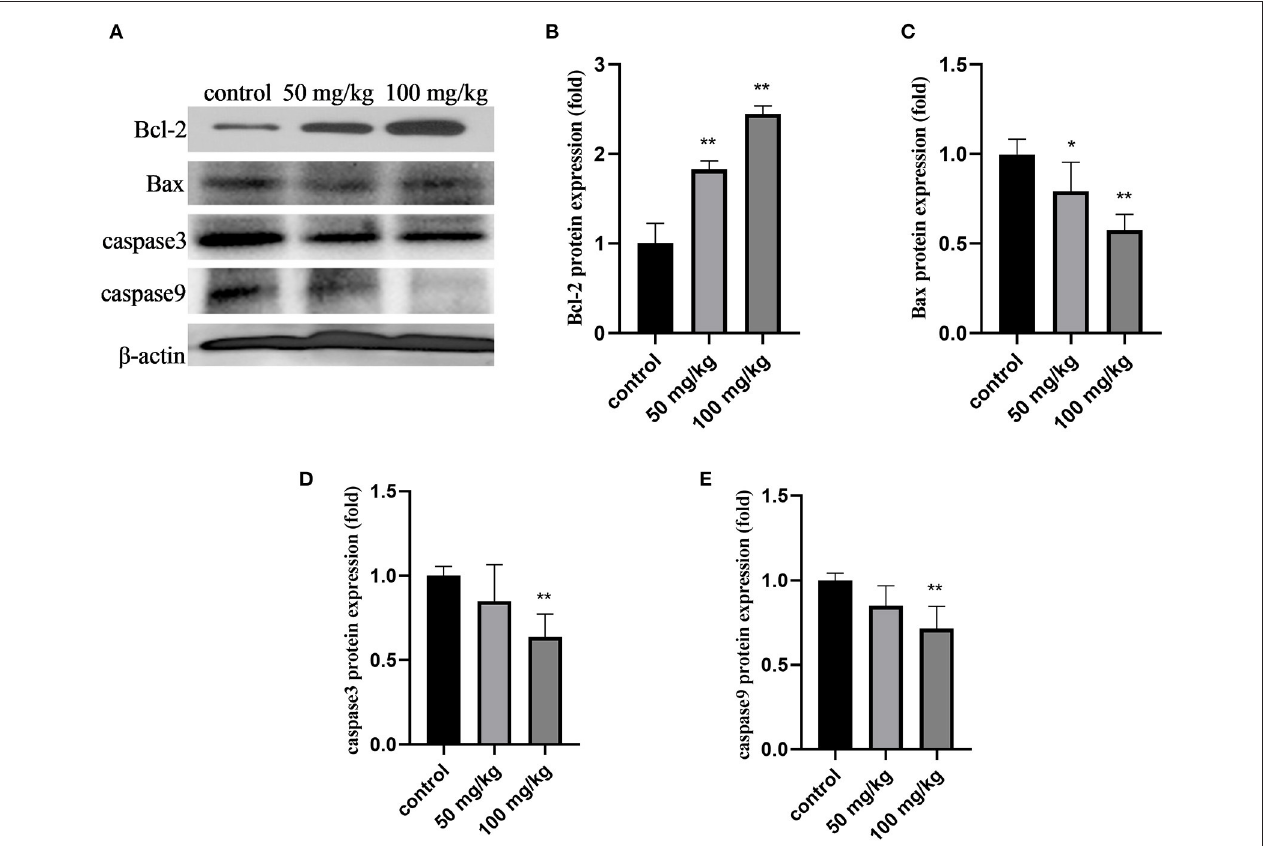
FIGURE 3 | Effects of rutin supplementation on apoptosis of mammary gland in sheep during the transition. (A) Western blot analysis of Bcl-2, Bax, caspase3 and caspase9. (B–E) Relative protein abundance of Bcl-2, Bax, caspase3 and caspase9. Data are presented as means ± SE. * P < 0.05, ** P < 0.01.